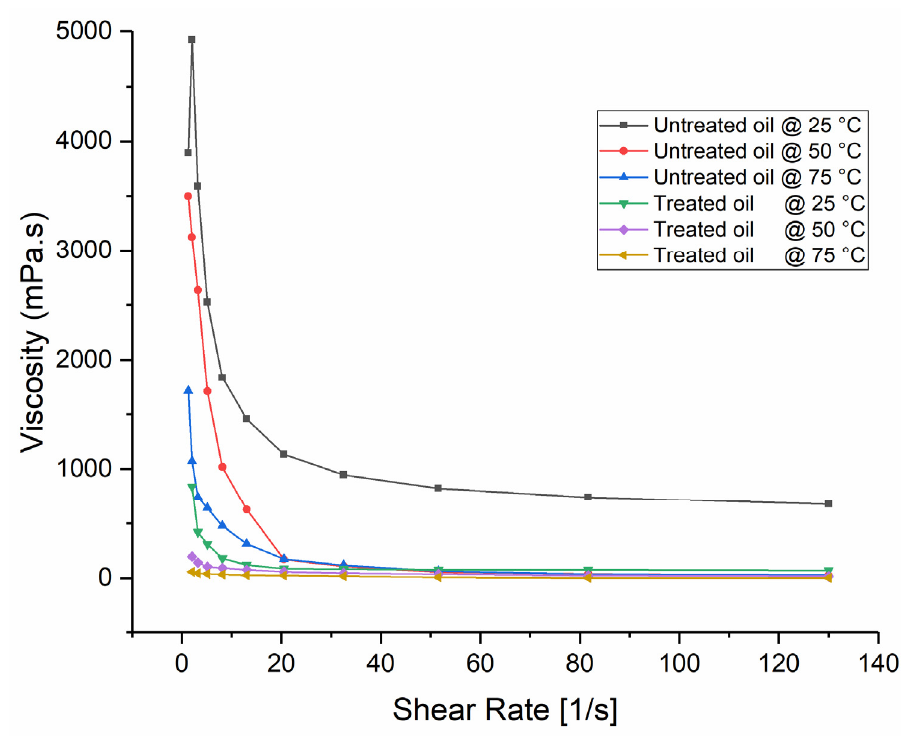
Figure 4. Viscosity flow behavior of crude oil before and after aquathermolysis at different temper- atures.